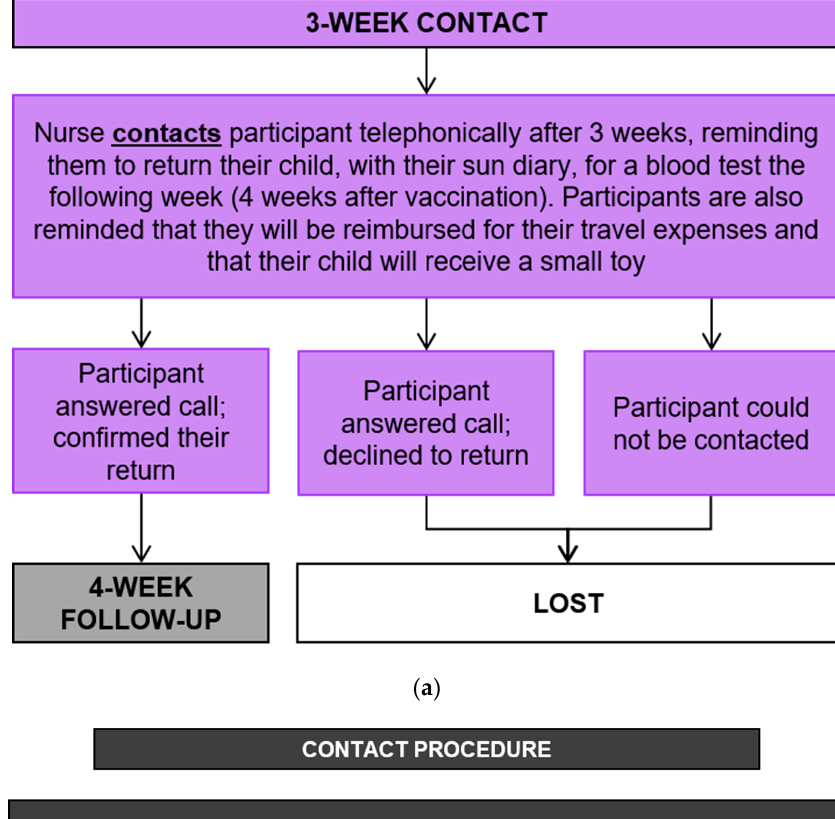
Figure 5. Vaccination stage flow chart.